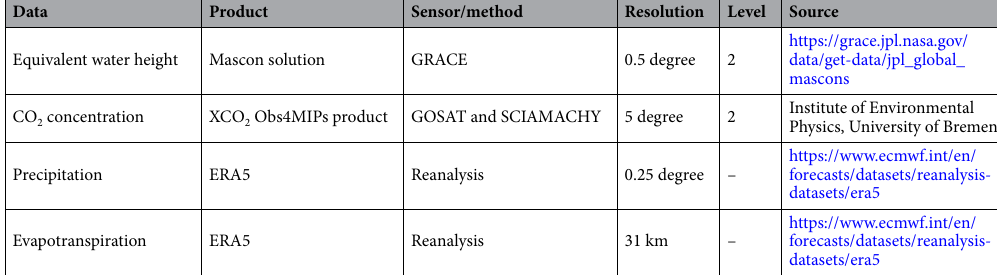
Table 1. Lists all the datasets used in this study, which are explained in the following